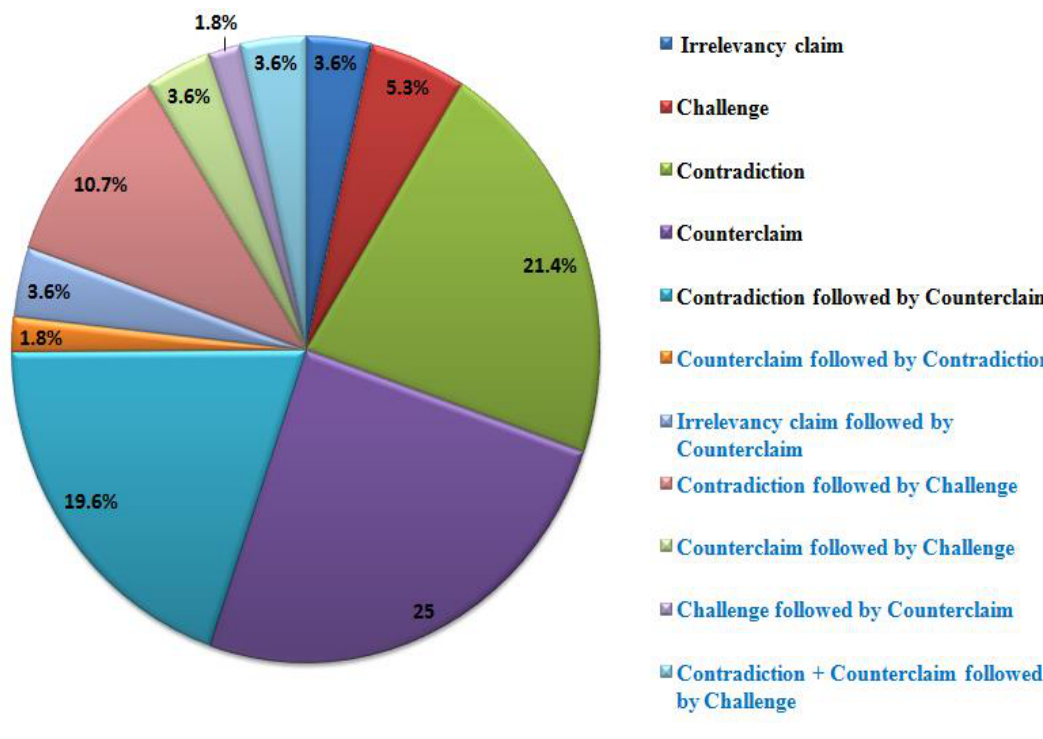
Figure 1: Male Criminals’ Disagreeing